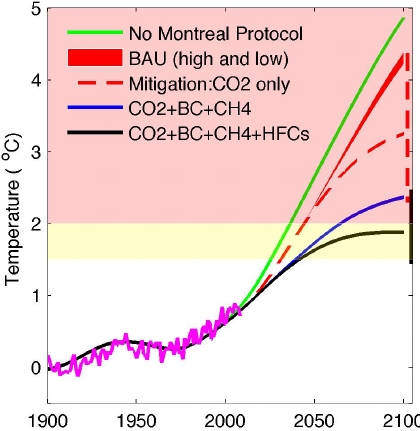
Fig. 2. Model simulated temperature change under various mitigation scenarios that include CO 2 and SLCPs (BC, CH 4 , HFCs). BAU case (red solid line with spread) considers both high and low estimates of future HFC growths (as shown in red solid and dash lines in Fig. 1). Note this uncertainty of temperature projection related to HFC scenarios is around 0.15°C at 2100. The vertical bars next to the curve show the uncertainty of temperature projection at 2100 due to climate sensitivity uncertainty. For simplicity, we only show the cases of CO 2 mitigation (red dash line) and full mitigation (black line).